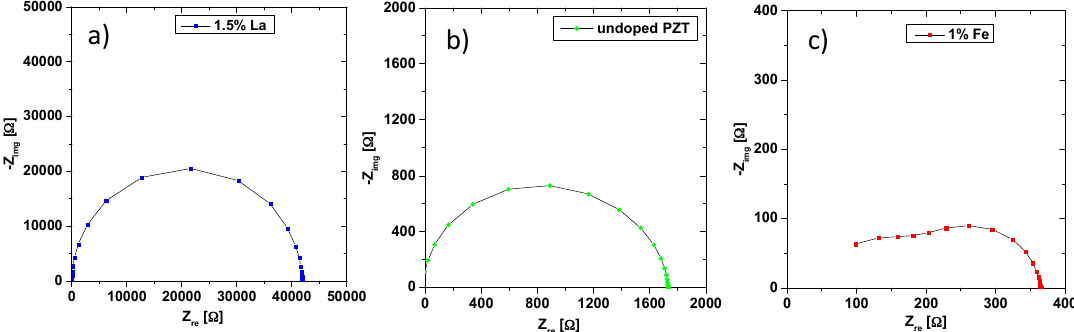
Figure 6. ( a ) Impedance spectrum of the 1.5% La-doped PZT at 560 °C—an almost ideal semicircle results; ( b ) impedance spectrum of the undoped sample at 560 °C; the semicircle is more distorted; ( c ) impedance spectrum of the 1% Fe-doped PZT at 560 °C. A splitting into two semicircles is visible. The absolute resistance values of the three spectra differ by two orders of magnitude.